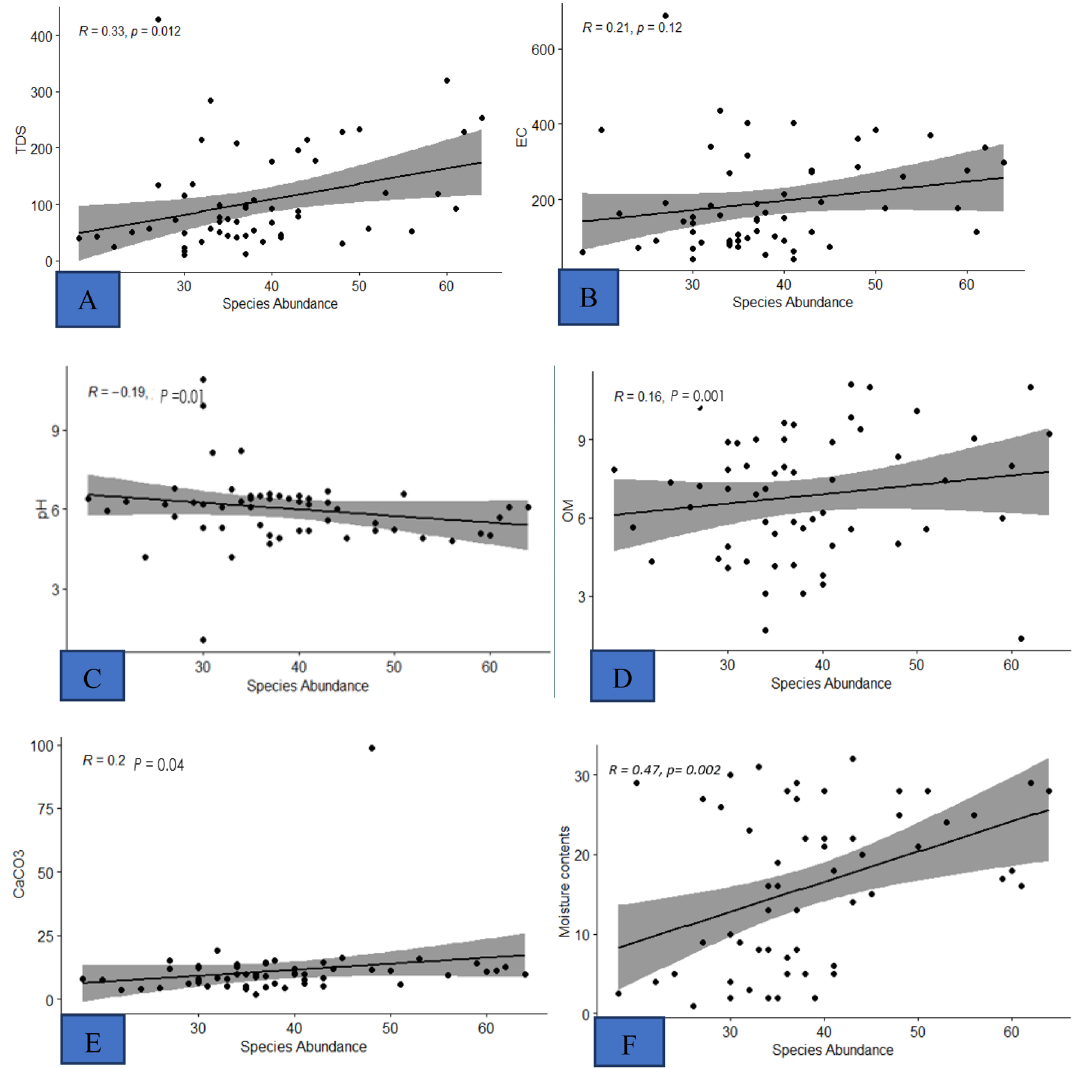
Figure 2. Regression analysis between soil variables and plant species abundance. Impact of soil ( A ) TDS ( B ) EC ( C ) pH ( D ) OM ( E ) CaCO 3 and ( F ) moisture contents with species